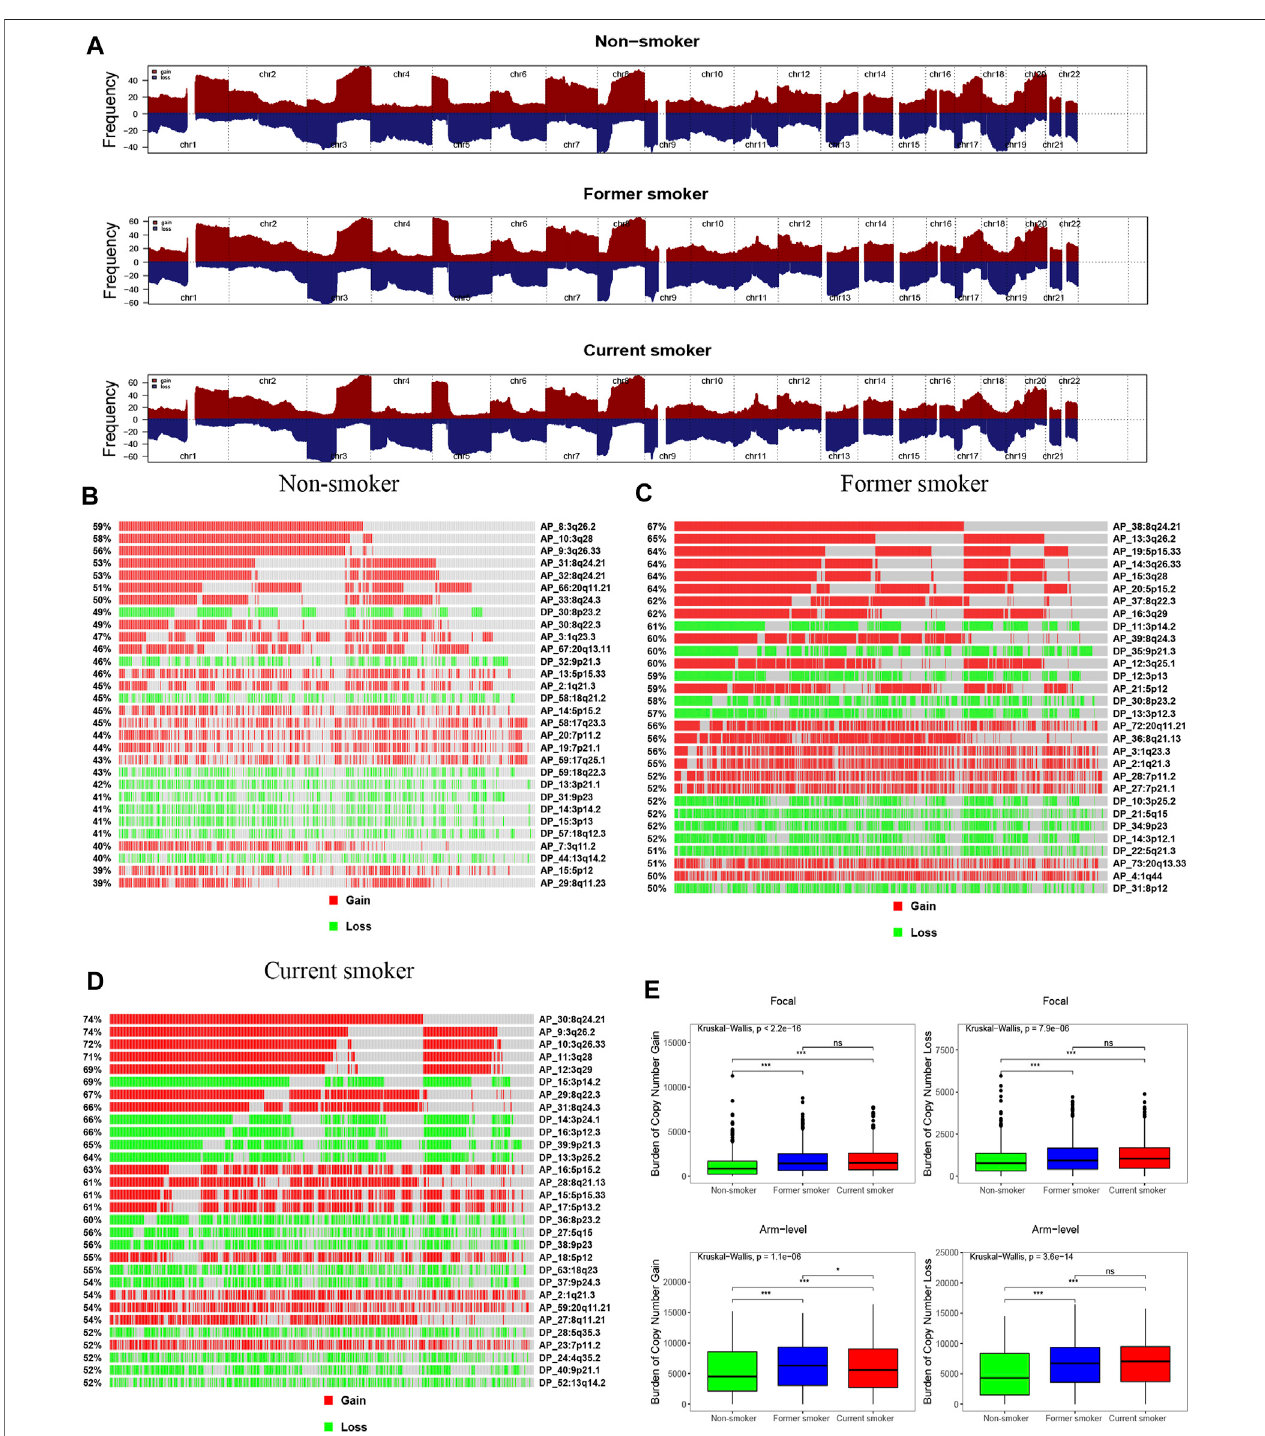
FIGURE6| Copy number pro fi les of patients with different smoking histories. (A) Gene fragments are placed on chromosomes ranging from chromosome 1 to 22, in which gain is dark red while loss is dark blue. Differences in the gene fragment distribution of CNV events in patients with different smoking histories [ (B) : non-smoker, (C) : former smoker, (D) : current smoker]. (E) Differences in CNV gain and loss burden at focal and arm in patients with different smoking histories.